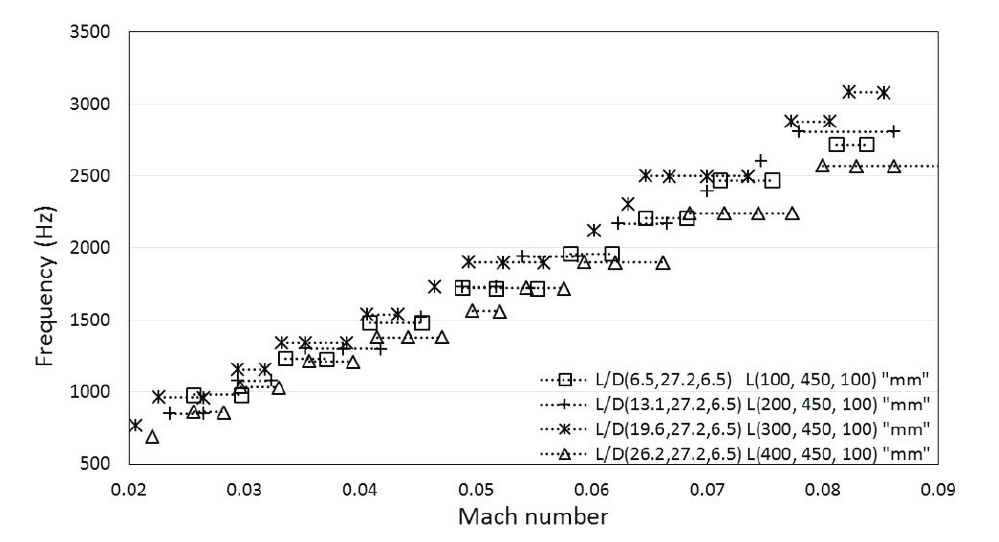
Figure 20. Frequency (Hz) plotted against Mach number M for L up = 100–400 mm, L corr = 450 mm, and L dw = 100